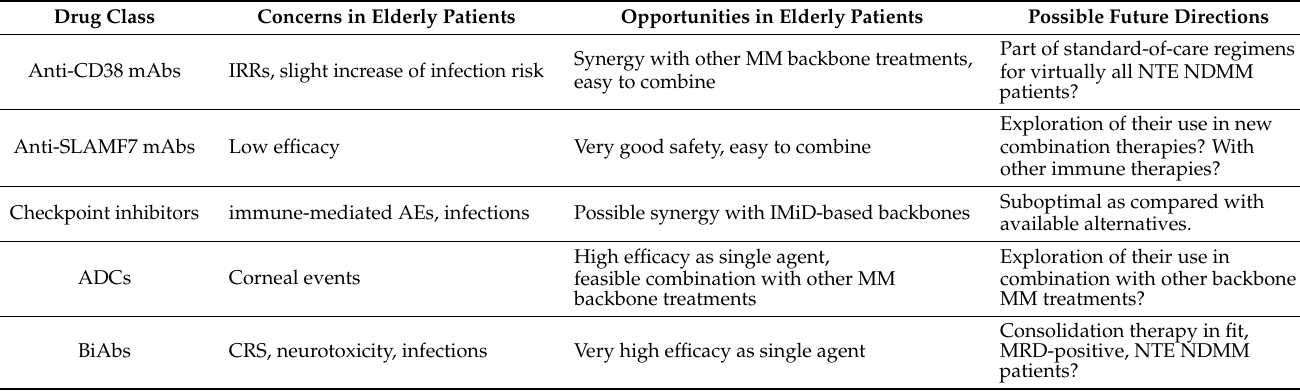
Table 2. Concerns, opportunities and possible future directions regarding the use of selected anti-MM mAb classes for the treatment of NTE NDMM